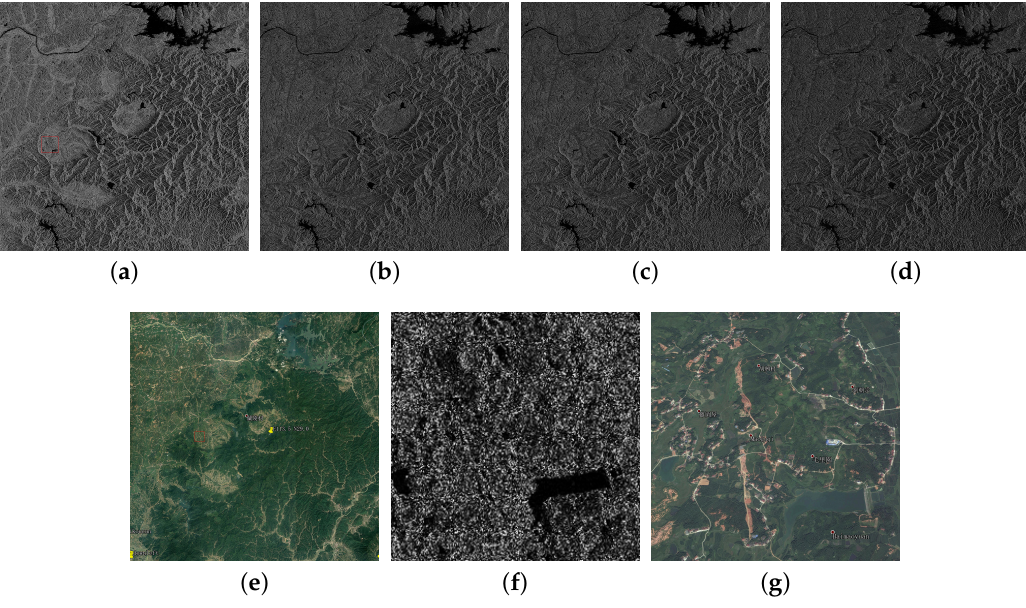
Figure 3. ( a ) HH; ( b ) HV; ( c ) VH; and ( d ) VV are fully polarimetric GF-3 images of YueYang city in Hunan province (17 August 2017) imaged in QPSI mode with 8 m resolution covering 884.7 square kilometers. Image size is 3859 × 3582 pixels. ( e ) The optical image of the same area obtained from Google Earth. ( f , g ) Selected areas of ( a , e ). Buildings are fused with other